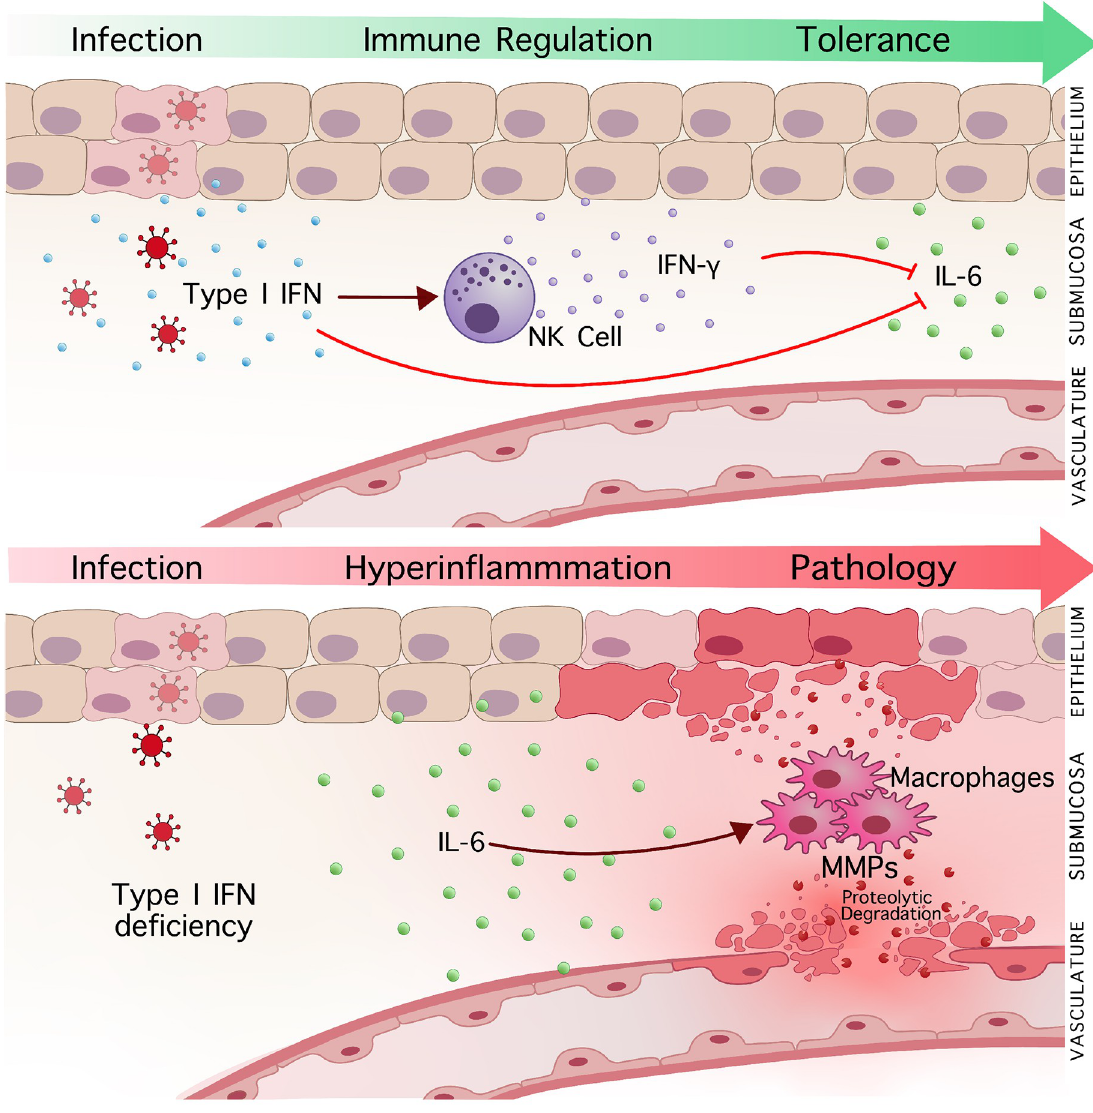
Fig 8. Type I IFN signaling prevents immunopathology during mucosal viral infection through inhibiting IL-6 and macrophage induced proteolytic degradation. (Top) Induction of type I IFN signaling suppresses heightened IL-6 production to mucosal viral infection and prevents the development of immune-mediated pathology. Concurrently, induction of NK cell activation and IFN- γ production, facilitated by type I IFN signaling, functions as a secondary mechanism to suppress IL-6-mediated inflammation and tissue pathology to infection. (Bottom) In the absence of type I IFN signaling, heightened IL-6 drives hyperinflammation and virus-induced pathology. Enhanced macrophage recruitment and MMP production by IL-6 induces severe tissue destruction following infection, and inhibition of MMP activity can significantly abrogate virus-induced